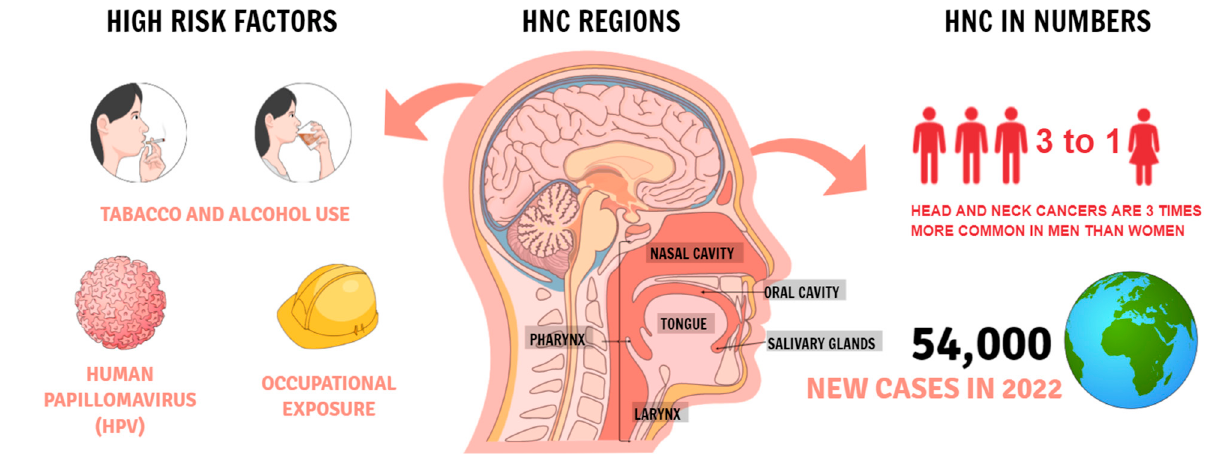
Figure 1. Head and neck cancer statistics according to the SEER.